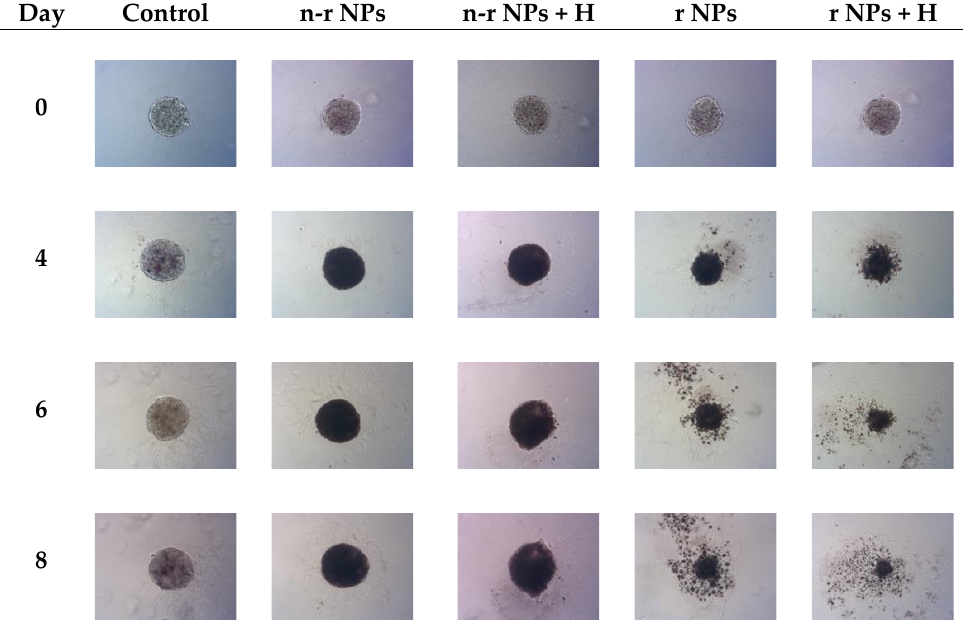
Figure 13. Spheroid growth over time treated with NPs bioconjugate or untreated (control): n-r—nonradioactive, r—radioactive, H—hyperthermia. Data are expressed as mean value ± SD ( n = 3).